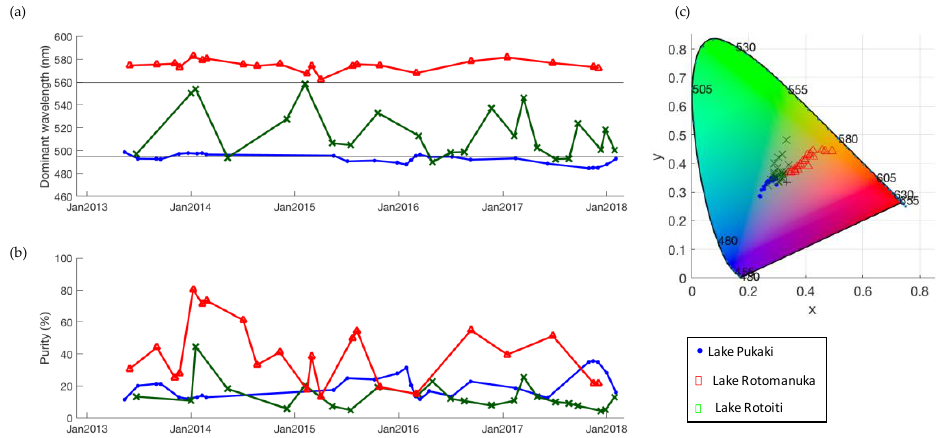
Figure 11. Three example time series of ( a ) dominant wavelength and ( b ) purity and the location of each observation in a chromaticity diagram ( c ). The horizontal lines in ( a ) indicate the boundary wavelengths between blue and green colour bins (495 nm) and green and yellow colour bins (560 nm). Lake Pukaki (44.0542 ◦ S, 170.1685 ◦ E), Lake Rotomanuka (37.9257 ◦ S, 175.3152 ◦ E), and Lake Rotoiti (38.0358 ◦ S, 176.4174 ◦